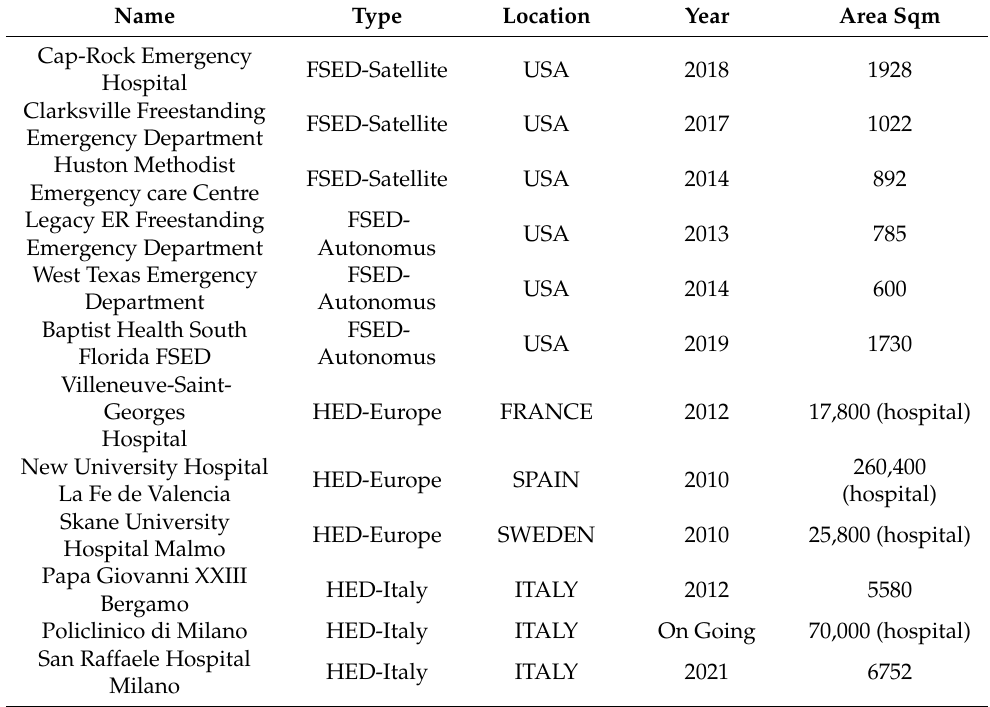
Table 1. List of case studies analyzed and criteria of